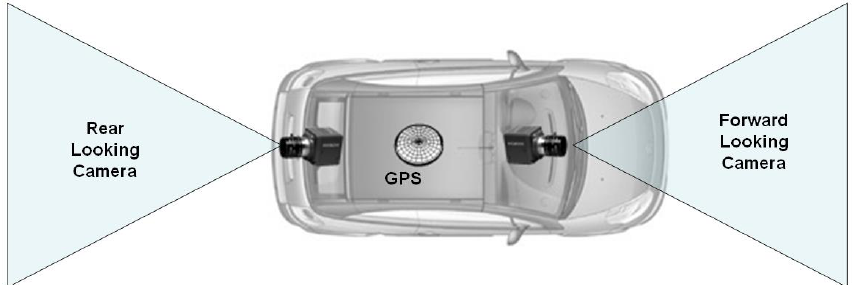
Figure 1. Traffic data collection sensor comprising two cameras and a GPS.